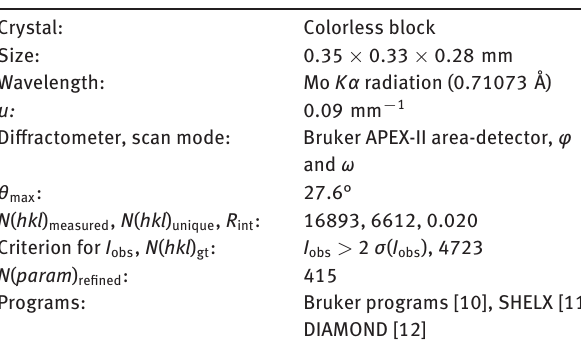
Table 1: Data collection and